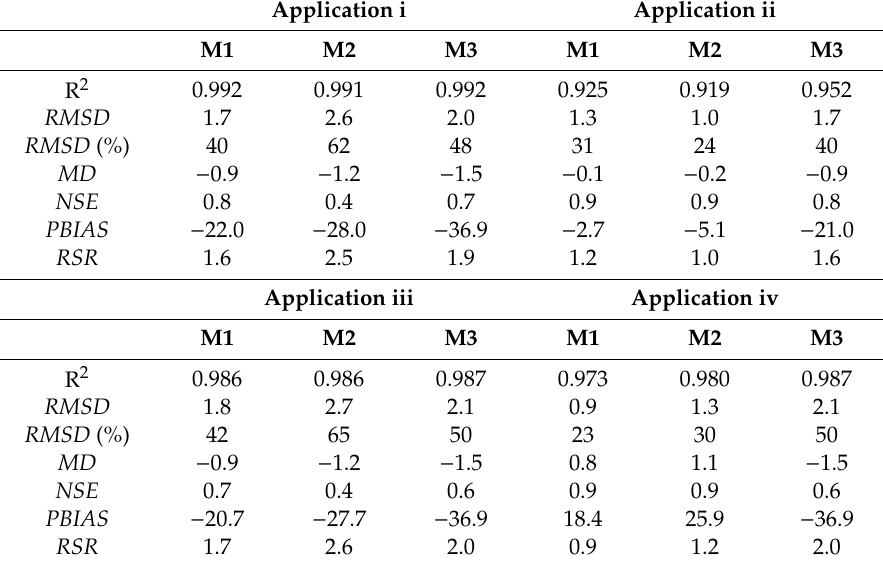
Table 8. Statistical parameters obtained for the average volumetric flow rate for the greenhouse G M,sim (simulated with the di ff erent models M1, M2 and M3) with the experimentally observed values G M,obs . R 2 , determining coe ffi cient; RMSD , root mean squared error; MD , bias ; NSE , the Nash-Sutcli ff e e ffi ciency; PBIAS , percent bias ; RSR , RMSD -observations standard deviation ratio. Applying the models with mean values of C w and the particular discharge coe ffi cients C dVS and C dWR for each test (Application i), with mean values of C w , C dVS and C dWR (Application ii); with mean values of C w and the fits C dVS ( u o ) and C dWR ( u o ) (Application iii); with fits C w,M1 ( δ ), C w,M2 ( δ ), C dVS ( u o ) and C dWR ( u o ) (Application